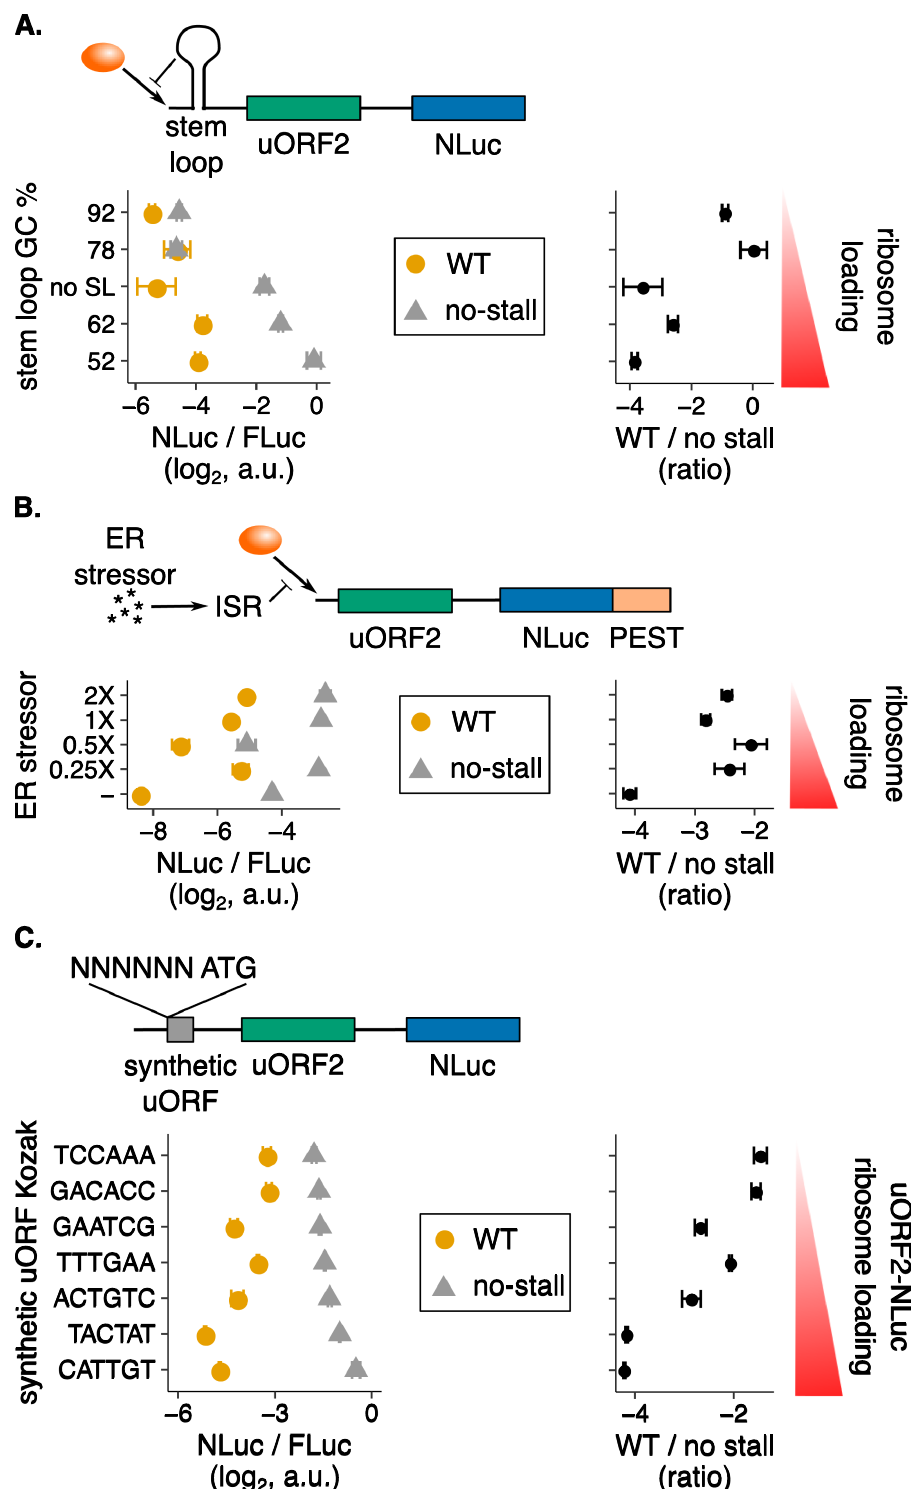
Fig 5. The human cytomegaloviral uORF2 buffers against reductions in main ORF protein output. The human cytomegaloviral UL4 uORF2 is used in the dual-luciferase assay (Fig 2B) in conjunction with three experimental strategies to reduce ribosome loading. (A) Ribosome loading is reduced using stem-loops [76] with the indicated GC percentages. All stem-loops are positioned 8 nt from the 5 0 cap and have the same predicted stability of -30